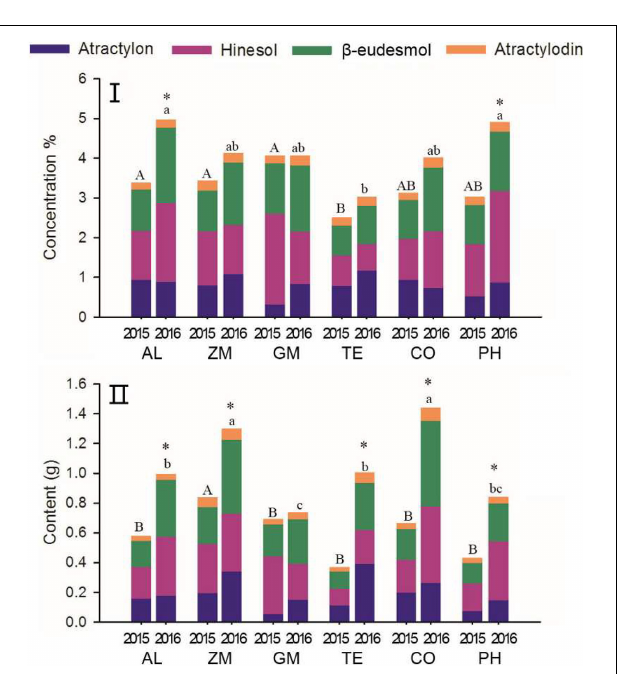
FIGURE 6 | The effect of different intercropping treatments on concentration (I) and content (II) of total volatile oils in 2015 and 2016. Different capital (2015) and lowercase (2016) letters indicate significant differences at the 5% significance level, and asterisks indicate significant differences between 2015 and 2016 within individual treatments.